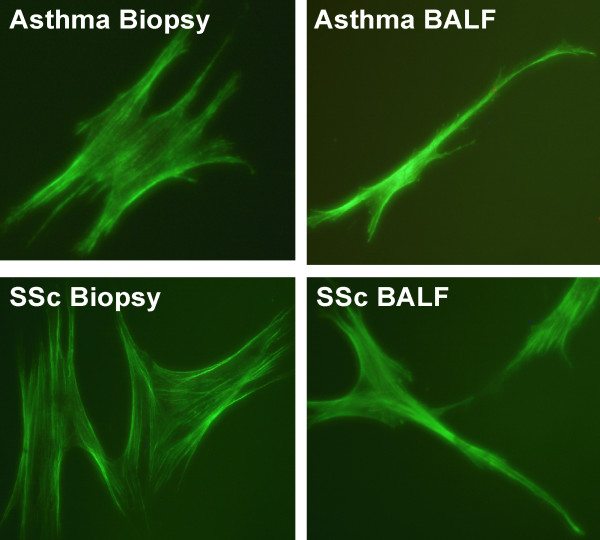
Actin expression in fibroblasts from BALF and bronchial biopsies from patients with SSc and mild asthma are arranged into stress fibers. Fibroblasts were cultured from bronchial biopsies and BALF from patients with SSc and mild asthma. Cells were seeded on four-well chamber slides (5000 cells/well), stained with Alexa Fluor™ 488 phalloidin showing stress fibers and analyzed using a fluorescence microscope.